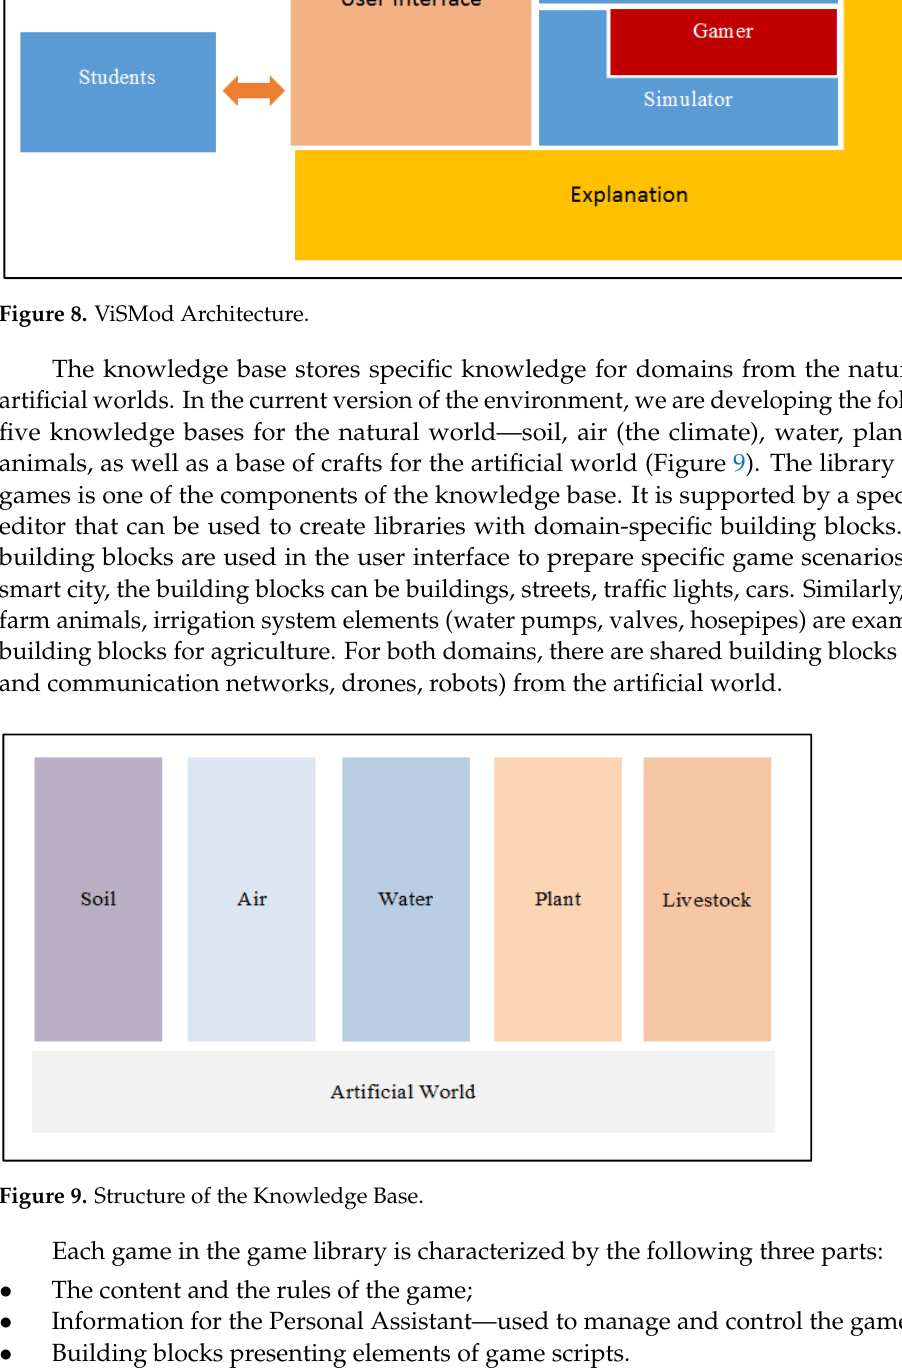
9 of 24 Figure 7. Protocol and statistics about the test results (in Bulgarian). DeLC 2.0 has been successfully used at the FMI of Plovdiv University for over 30 academic disciplines. The library and test system are the most commonly used services by teachers and students. The SCORM content is increasingly applicable in the COVID- 19 situation due to the need for online training. Students using SCORM textbooks can be navigated by the SCORM Player, which creates the feeling of controlled presentation of the material much like when teaching it in a real environment. 3.2. ViSMod ViSMod is the second basic component of VES, which provides tools for modeling processes, scenarios, and systems from different application areas. The aim is for the modeling tools to be developed by students within the framework of their training in the disciplines of Artificial intelligence and Logical programming. At the same time, in the